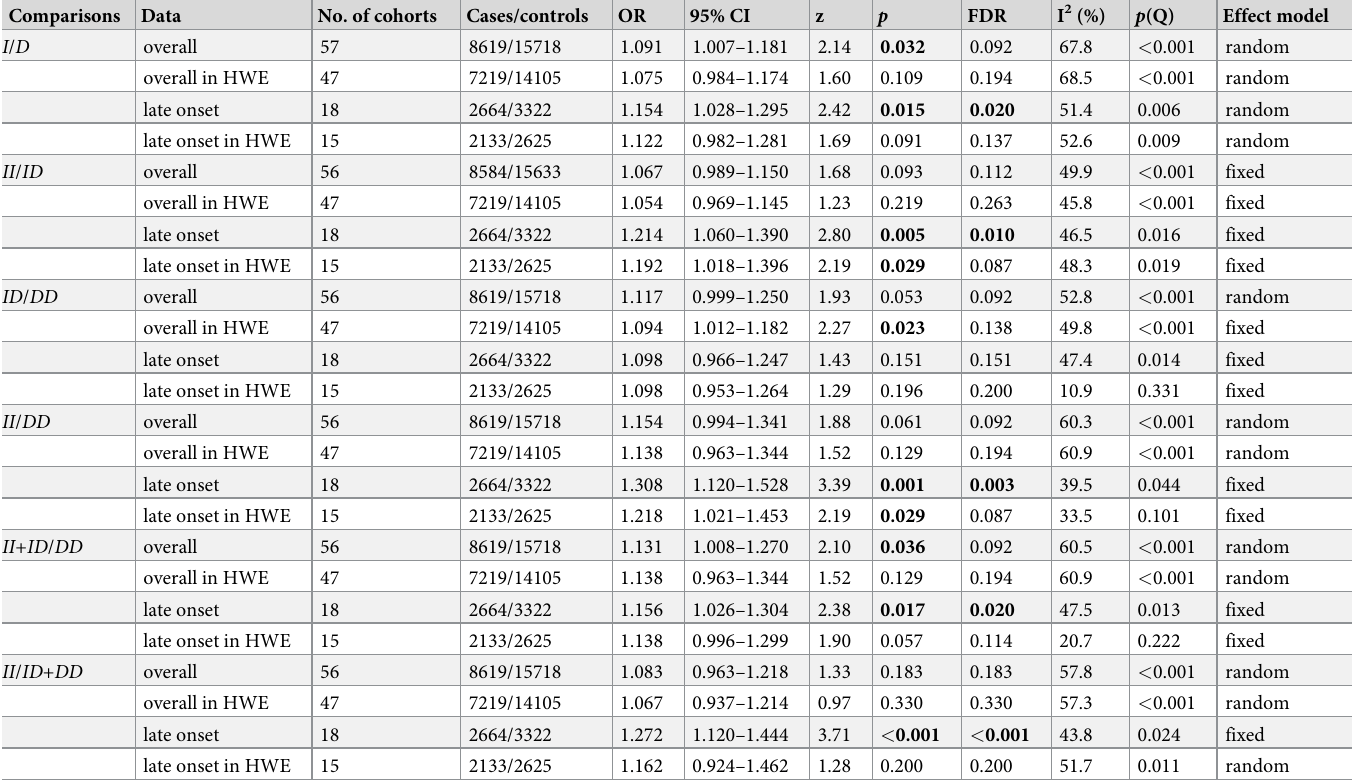
Table 3. Pooled odds ratios for rs1799752 polymorphism and AD